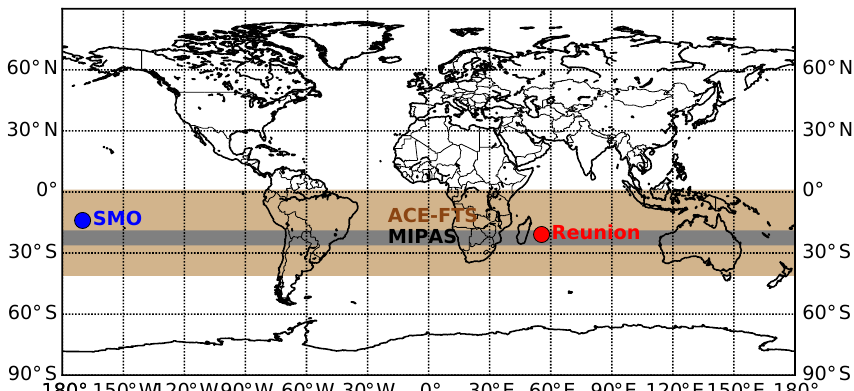
Figure 4. The locations of the ground-based sites (Reunion Island and SMO) as well as the latitude bands covered by the satellites (MIPAS and ACE-FTS).